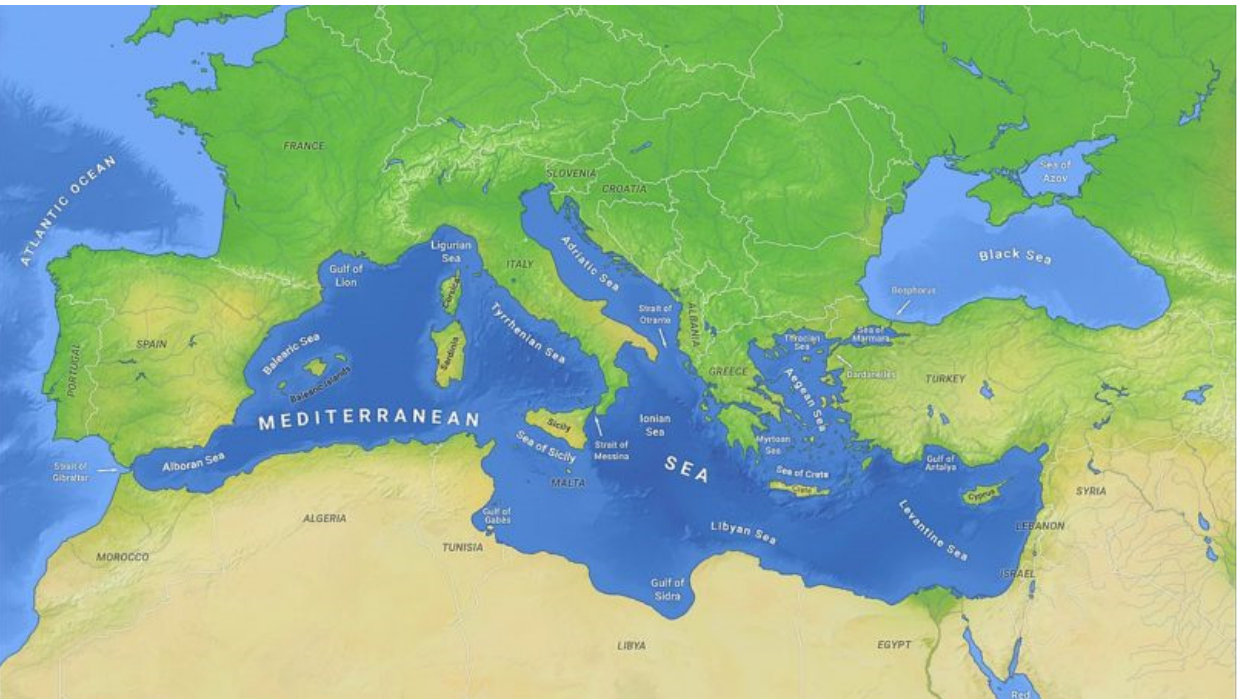
Figure 1. The Mediterranean Sea and region.